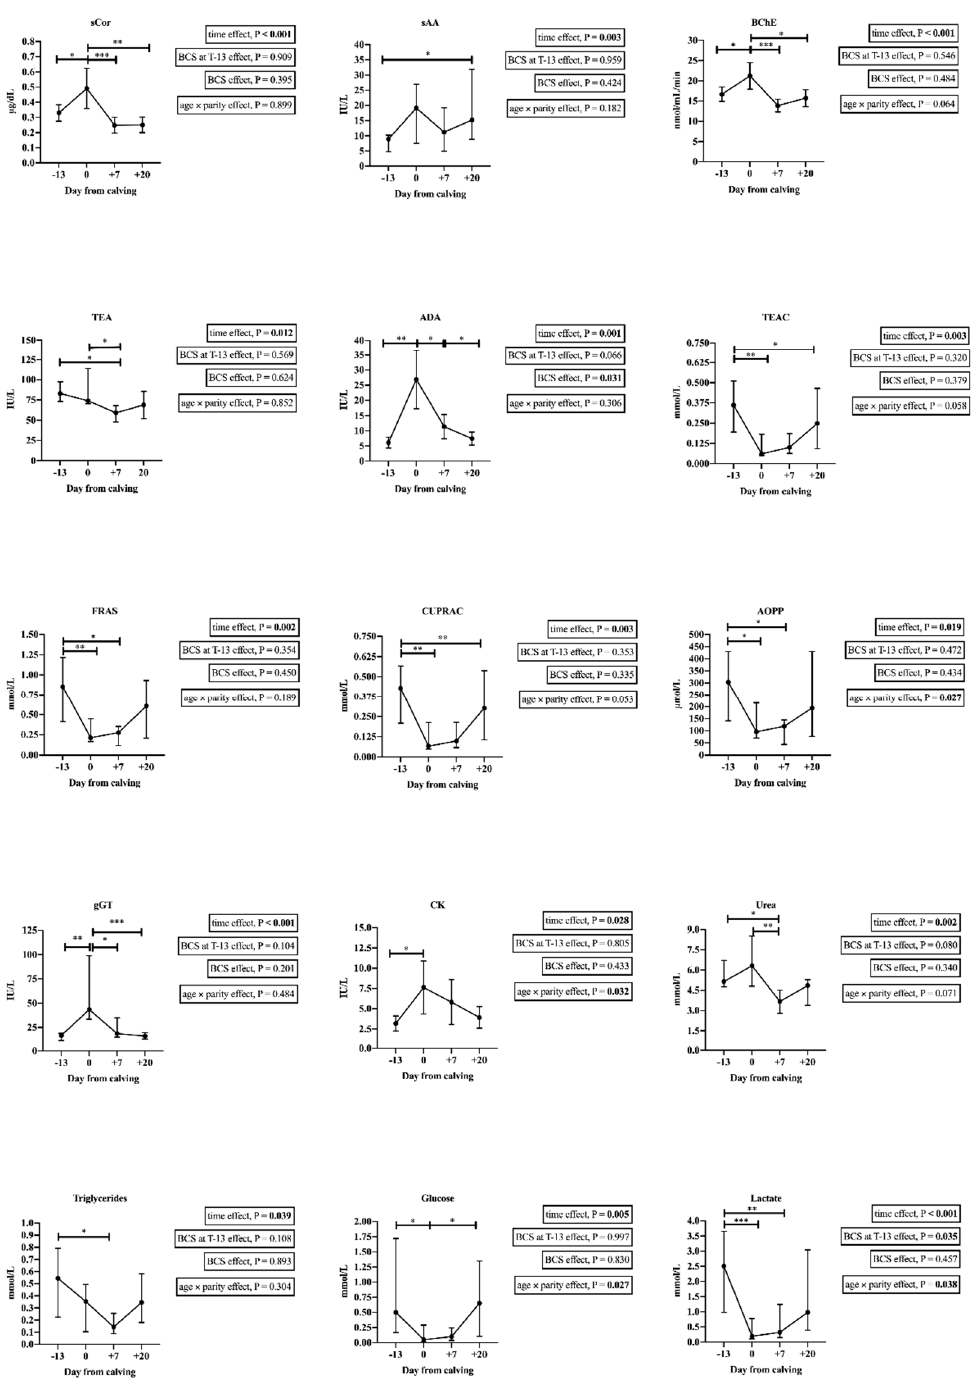
Figure 1. Results of salivary cortisol (sCor), salivary alpha-amylase (sAA), butyrylcholinesterase (BChE), adenosine deaminase (ADA), Trolox equivalent antioxidant capacity (TEAC), ferric reducing ability of saliva (FRAS), cupric reducing antioxidant capacity (CUPRAC), advanced oxidation protein products (AOPP), γ -glutamyl transferase (gGT), creatine kinase (CK), urea, triglycerides, glucose, and lactate in saliva of thirteen healthy dairy cows during their peripartum